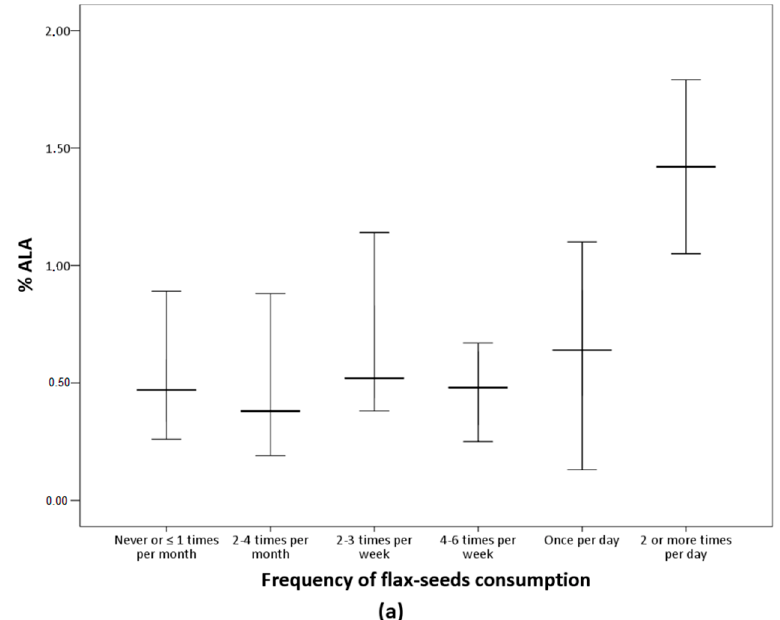
Table 5. Frequency of consumption of foods according to n -6/ n -3